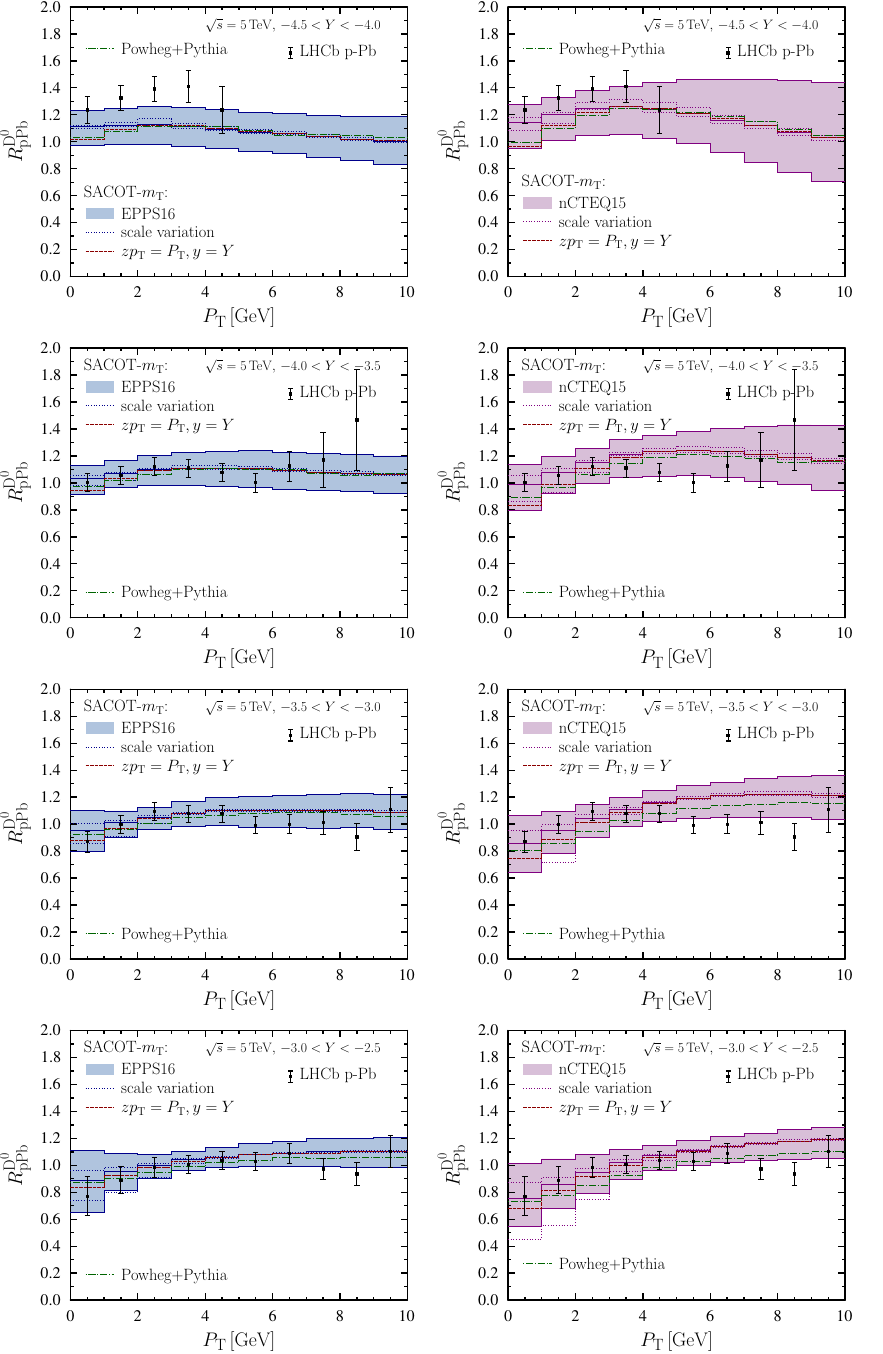
Figure 3 . Nuclear modi(cid:12)cation ratio for D 0 production in p+Pb collisions in di(cid:11)erent backward- rapidity bins from the LHCb measurement [42] (black points with error bars) and the SACOT- m T calculation with the EPPS16 (left) and nCTEQ15 (right) nPDFs. In addition to the central result (solid) and the nPDF-originating uncertainties (coloured bands), the scale variations (dotted band) and the result with massless de(cid:12)nition of the fragmentation variable (dashed) are shown, as well as the Powheg + Pythia predictions